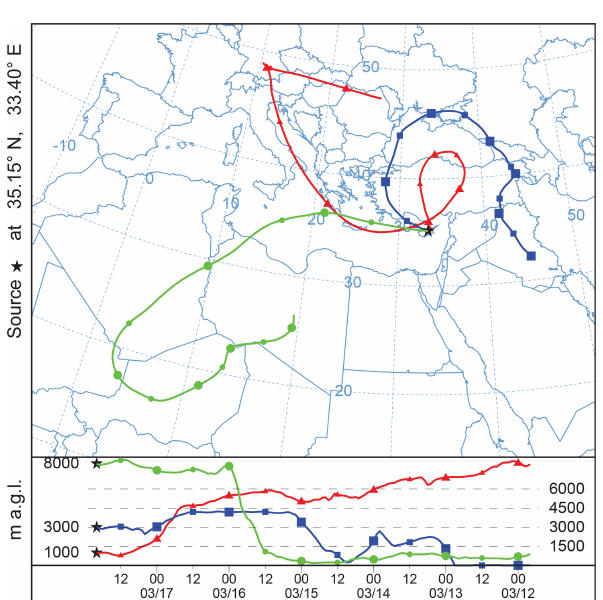
Figure 11. HYSPLIT backward trajectories for 6d arriving at Nicosia, Cyprus, on 17 March 2015 at 20:00UTC (see Fig. 5e and f). The computations are based on GDAS0.5 meteorological fields. Arrival heights are 1000m (red, boundary layer), 3000m (blue, Middle Eastern dust layer), and 8000m (green, Saharan dust